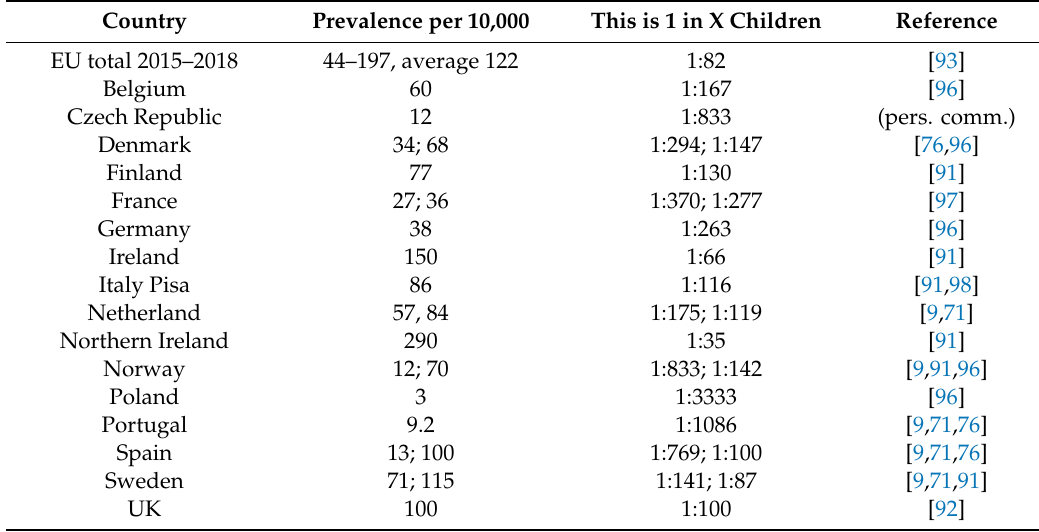
Table 3. The ASD prevalence in the EU member states according to the available last reports. Country This is 1 in X